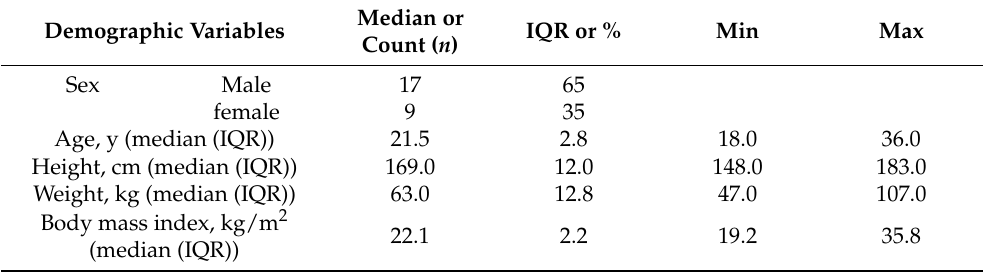
Table 1. Participant characteristics ( n = 26).